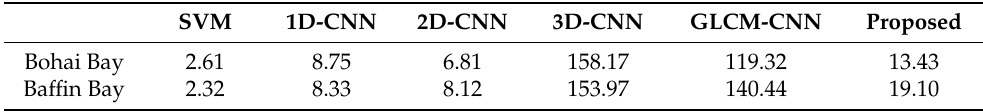
Table 11. Training time (seconds) for different methods. SVM